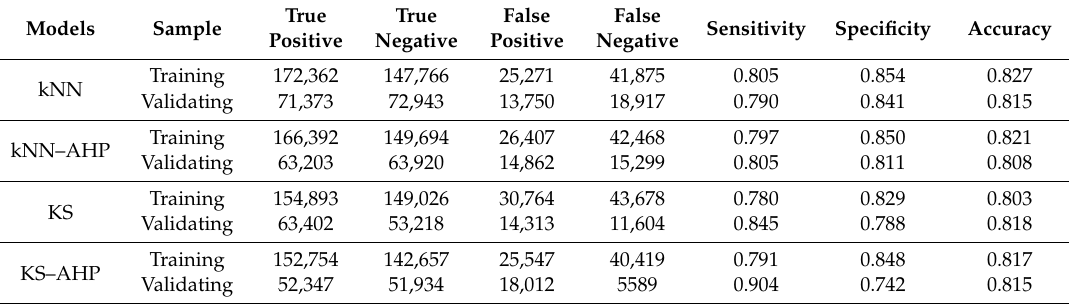
Table 2. Model performance based on the training and validating datasets.